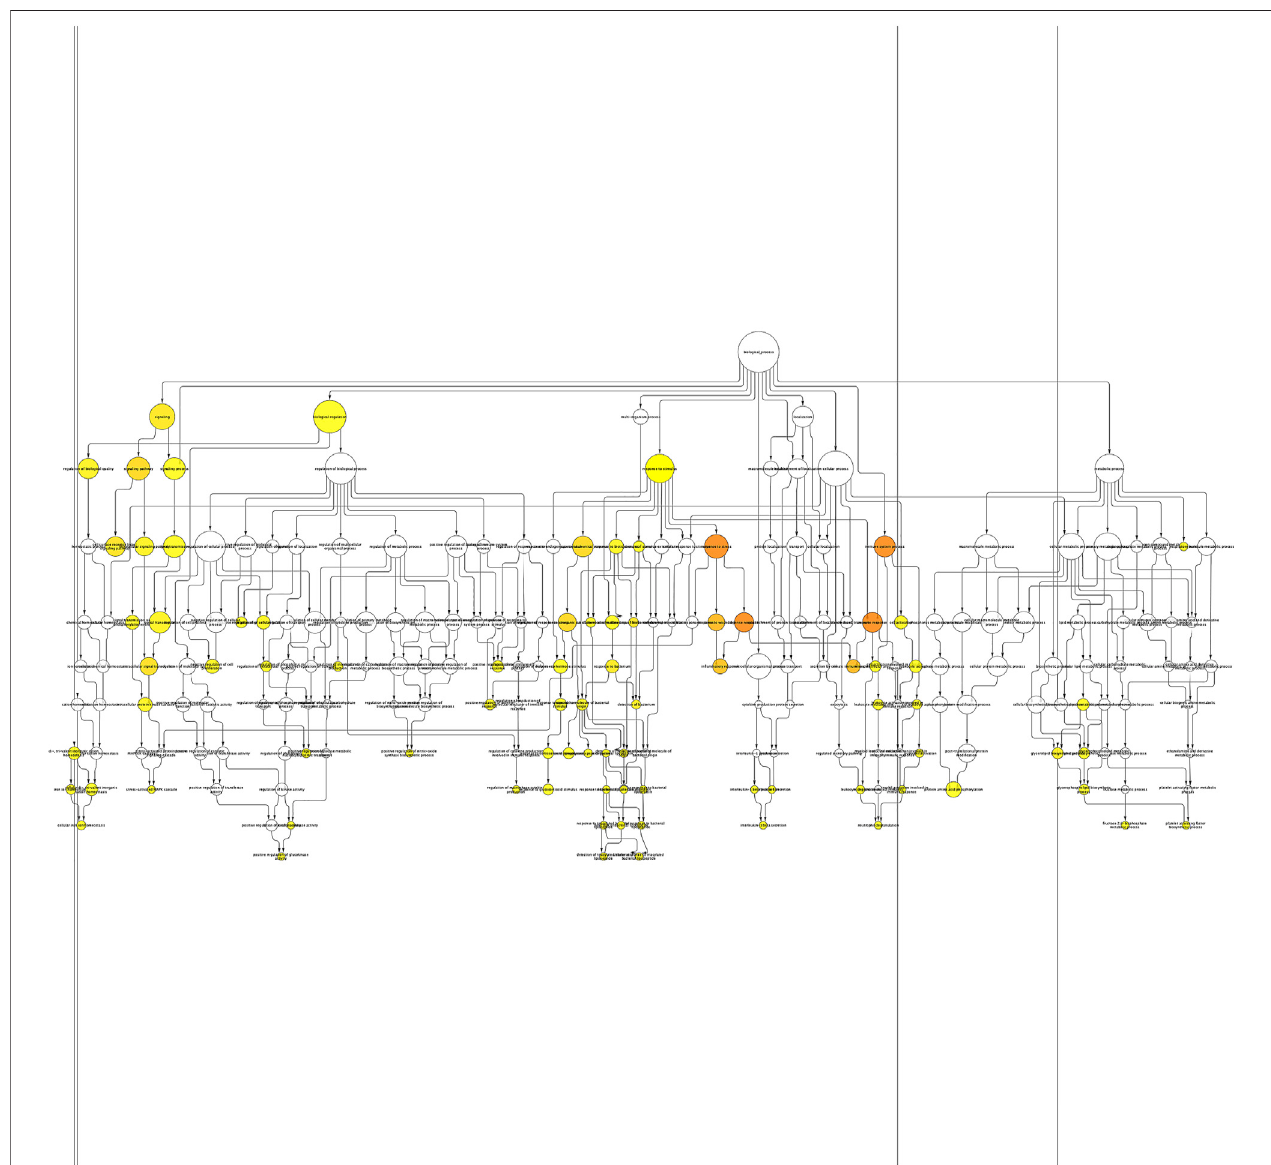
FIGURE 2 | Enrichment network of the shared DEGs based on biological processes. Biological process network of differentially expressed genes of KD patients usingtheBINGOappofCytoscape.Largenodesindicatemoregenesinvolved,andthesizeofanodeisproportionaltothenumberoftargetsintheGOcategory.Yellow nodes indicate the genes playing a signi fi cant role in KD: p -value <